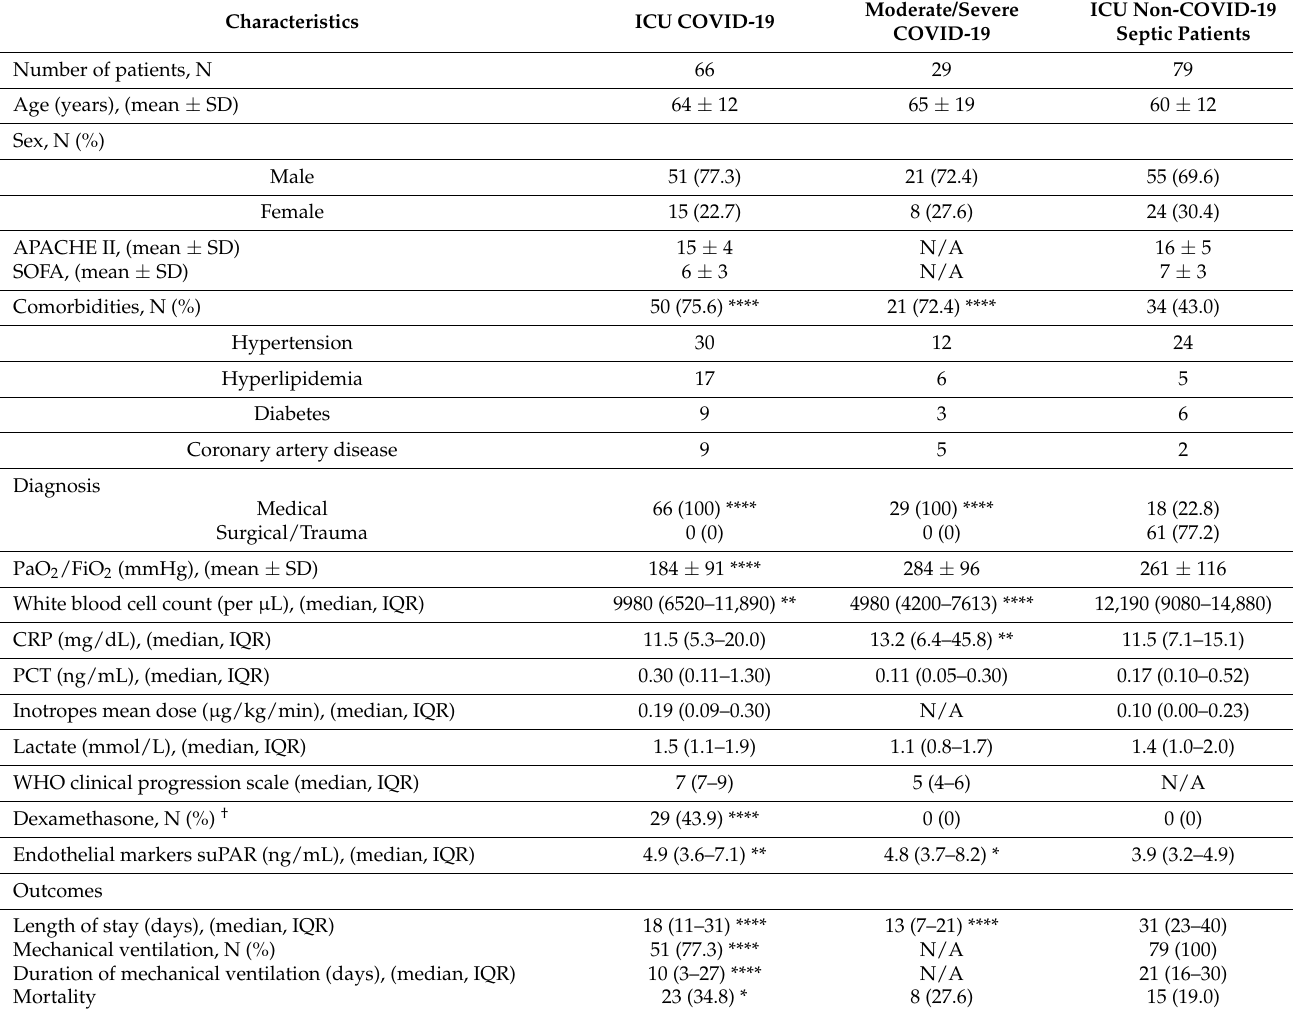
Table 1. Demographics and clinical characteristics of the